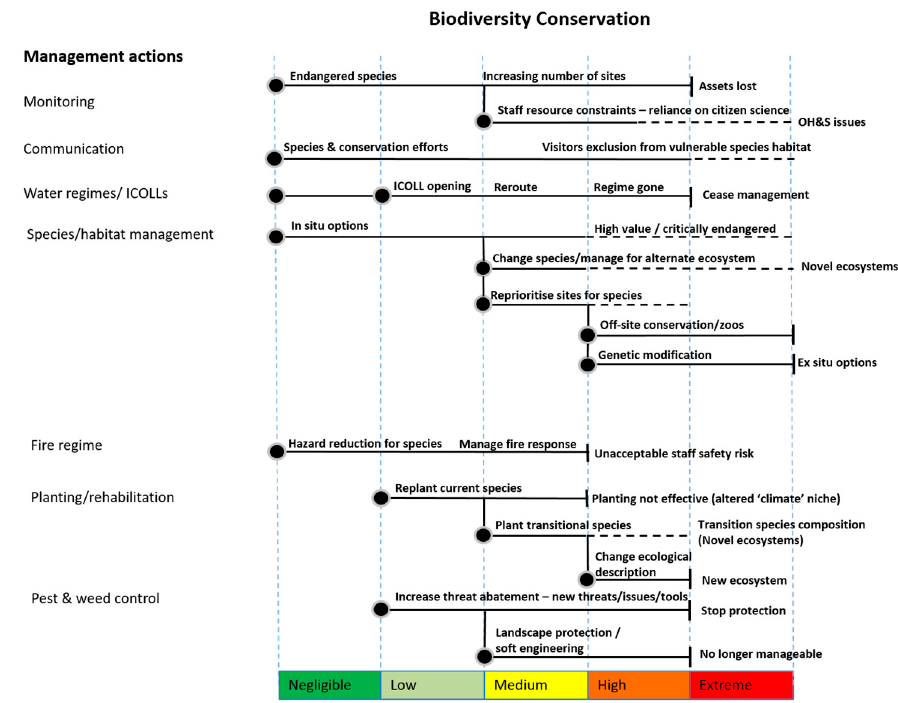
Figure 3. Adaptive management pathways under dynamic risk developed for biodiversity conservation. Black circles represent the beginning of a pathway or result from a disjunction along a pathway. Dotted lines represent uncertainty about the continuation of a pathway at a certain risk level.